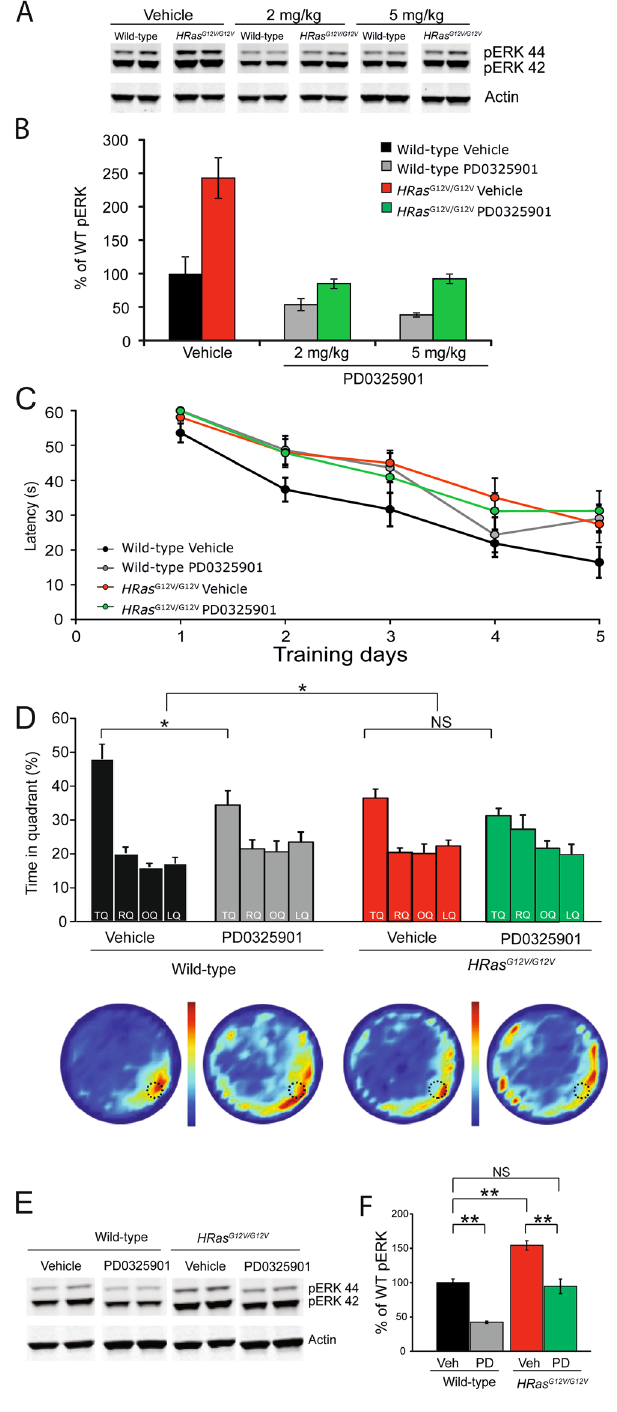
Figure 8. Inhibition of MEK with PD0325901 restores pERK levels but does not rescue the spatial learning deficit. ( A ) Western blots of hippocampal lysates of WT and HRas G12V/G12V mice treated with vehicle, 2 and 5 mg/kg of PD0325901. ( B ) Quantification of Western blots showing that both doses used affect pERK levels in both wild-type and HRas G12V/G12V mice. For both 2 and 5 mg/kg: effect of genotype: P < 0.01, effect of treatment: P < 0.01, interaction genotype * treatment P < 0.01. Data are presented as mean ± SEM from 6 mice per group. Two mice per group are depicted in the example blot. Statistical test: two-way ANOVA. ( C ) Average latency to platform for each day of training, per genotype. On average longer latencies were observed in vehicle and PD0325901 drug treated HRas G12V/G12V mice (effect of genotype P < 0.01). ( D ) Spatial memory assessed in a probe trial reveals a significant effect of genotype (P < 0.05) on time spent in the target quadrant (TQ). Although PD0325901 significantly reduced performance of wild-type mice, it showed no effect on mutant mice and no interaction of genotype and treatment was observed (P = 0.28). TQ = target quadrant, RQ = adjacent right quadrant, LQ = adjacent left quadrant, OQ = opposite quadrant. Heat plots present the data of all